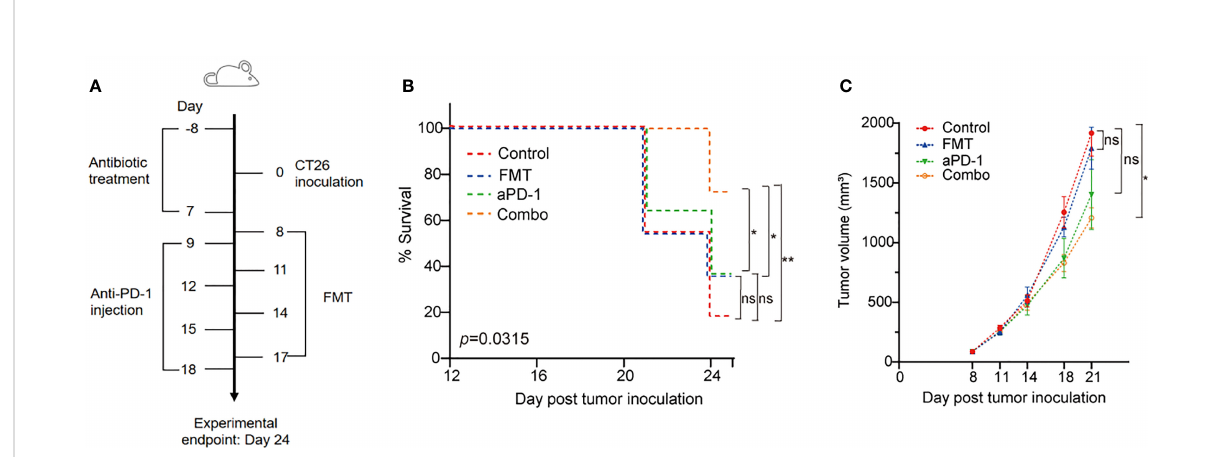
FIGURE 1 FMT and PD-1 antibody exerted synergistic anti-tumor effect in the CT26 tumor-bearing mice. (A) Schematic diagram of this study. (B) Survival curve of the CT26 tumor-bearing mice treated with FMT, aPD-1 or the combination. Statistical differences among four groups were examined using log-rank (Mantel-Cox) tests. Post hoc pair-wise comparisons were performed; *, p -value < 0.05; **, p -value < 0.01. (C) Tumor growth curves of the CT26 tumor-bearing mice treated with FMT, aPD-1 or the combination. Data are represented as mean ± SD (n = 10). Statistical differences were examined using Dunnett ’ s test; *, p -value <